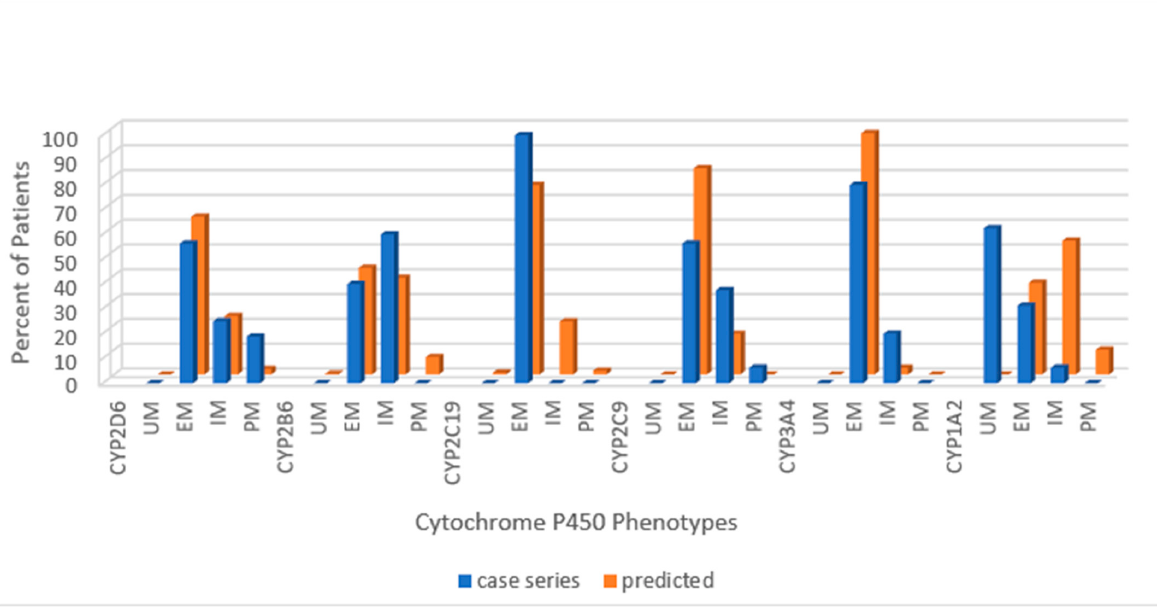
Figure 3. Distribution of Cytochrome P450 phenotypes among the PWS UPD cohort ( n = 16) compared to normative populations [https://www.pharmgkb.org/page/cyp2d6RefMaterials]; [https://www.pharmgkb.org/page/cyp2b6RefMaterials]; [https://www.pharmgkb.org/page/cyp2c19RefMaterials]; [https://www.pharmgkb.org/page/cyp2c9RefMaterials]; [20,27]. Note: There were 15 results for cytochromes 2B6 and 3A4. Key: UM—ultra-rapid metabolizer; EM—extensive metabolizer; IM— intermediate metabolizer; PM—poor